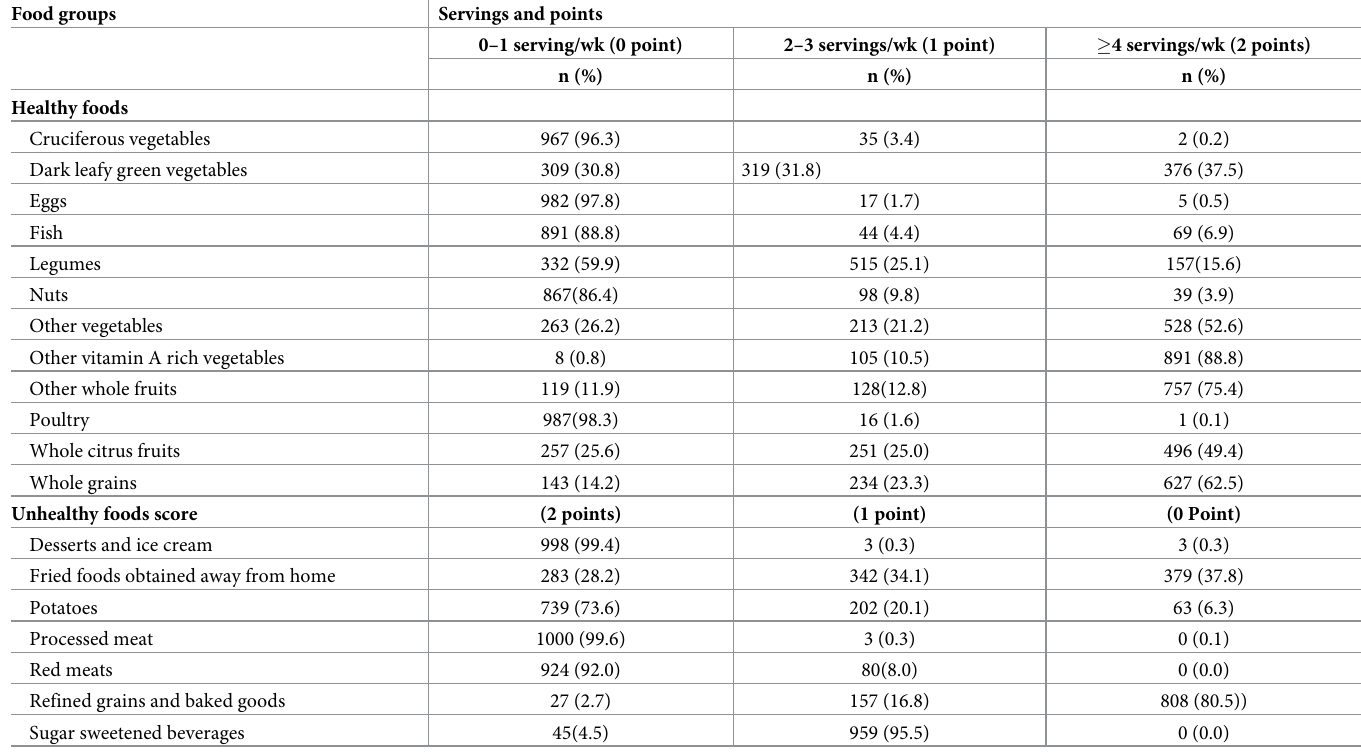
Table 3. Prime dietary quality score food groups consumed per week (N = 1004).